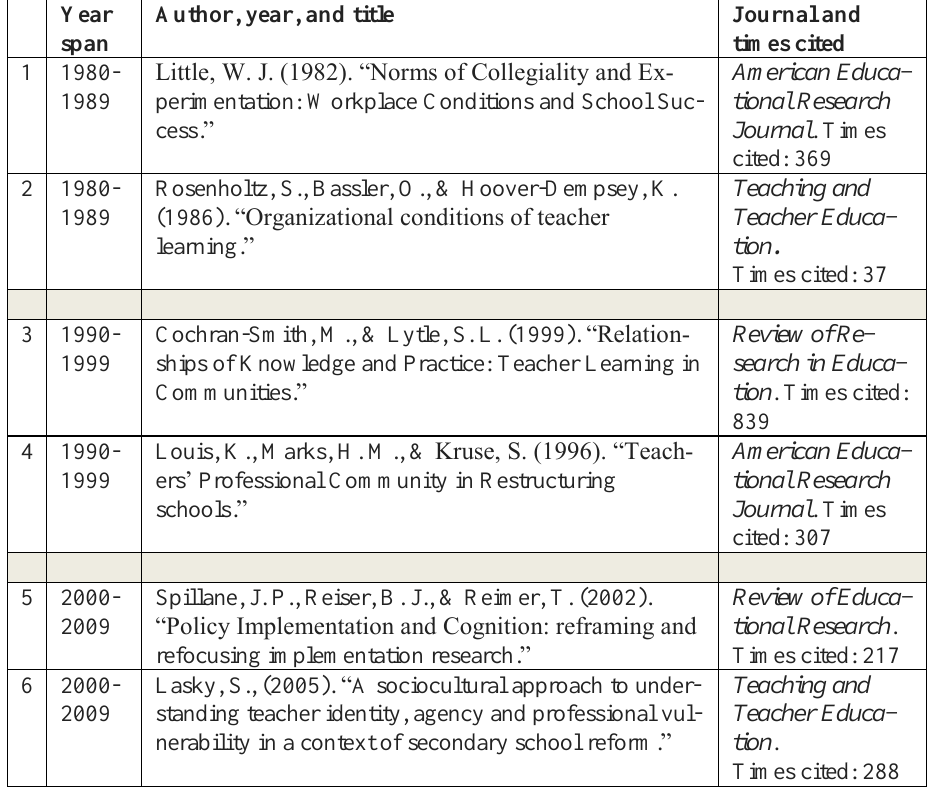
Table 1a Articles chosen for the